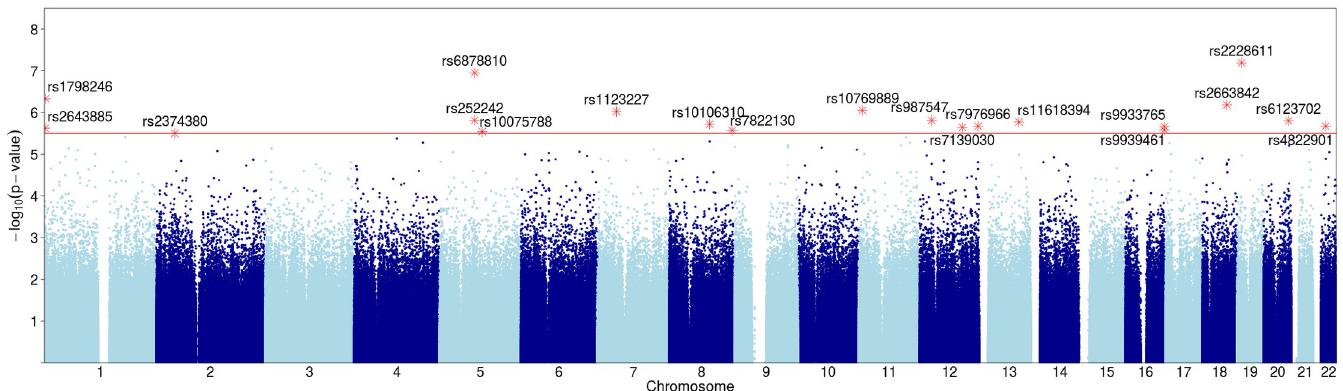
Fig 3. The Manhattan plots show significant SNPs for pleiotropy with growth parameters and Bayley phenotypes. Y-axis shows p-values (negative log scale) of three-way dependencies of SNPs, Bayley phenotypes, and each of the three Growth parameters: a ) linf, b ) lambda, and c ) alpha. SNPs with p-value < 3.2x10-6 (red line) are highlighted and